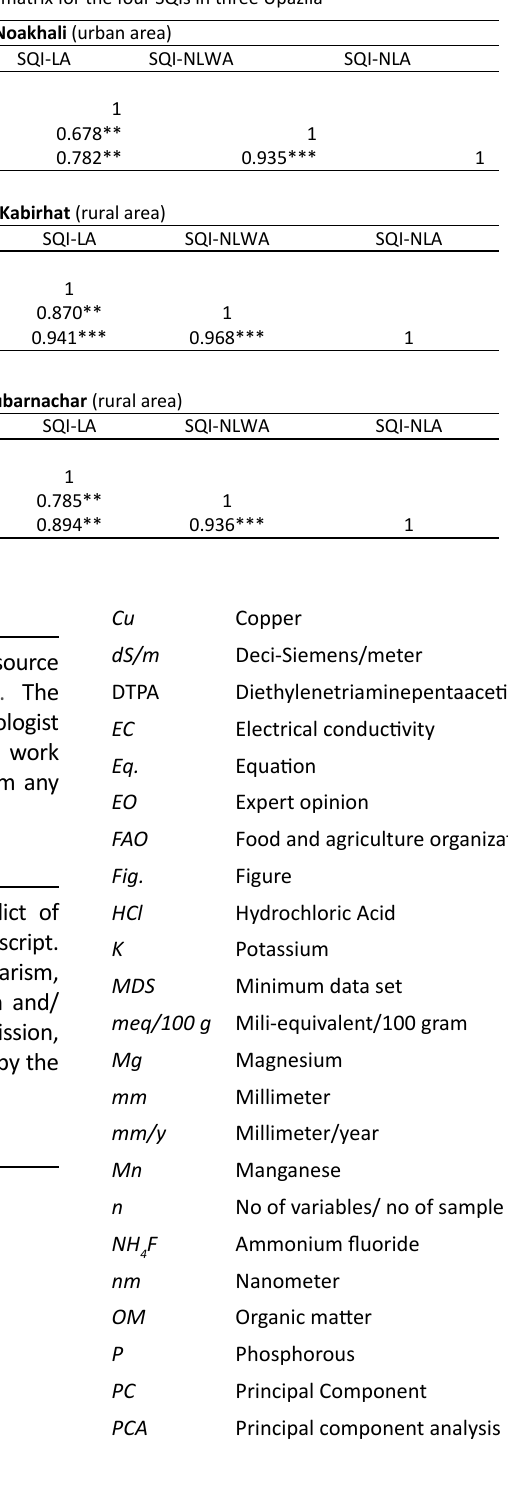
Table 6: Correlation matrix for the four SQIs in three Upazila